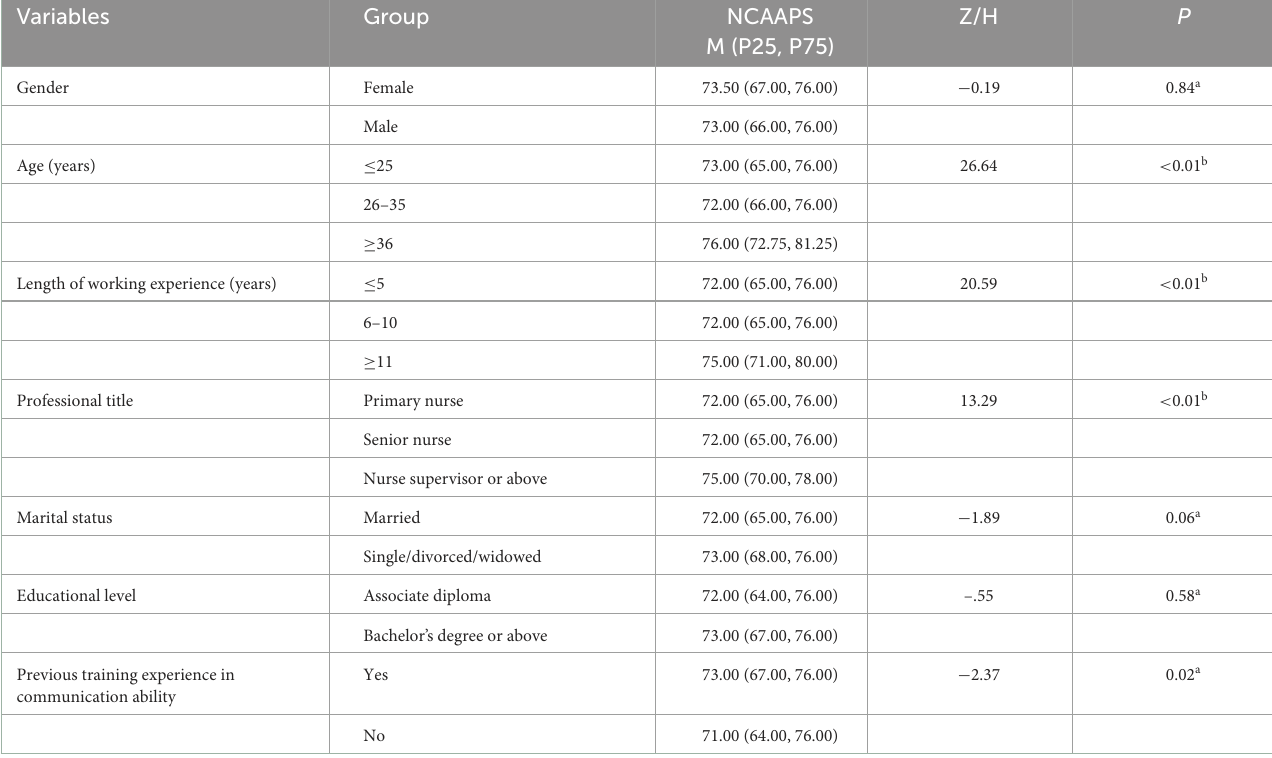
TABLE 3 Differences in NCAAPS by sample characteristic ( N =